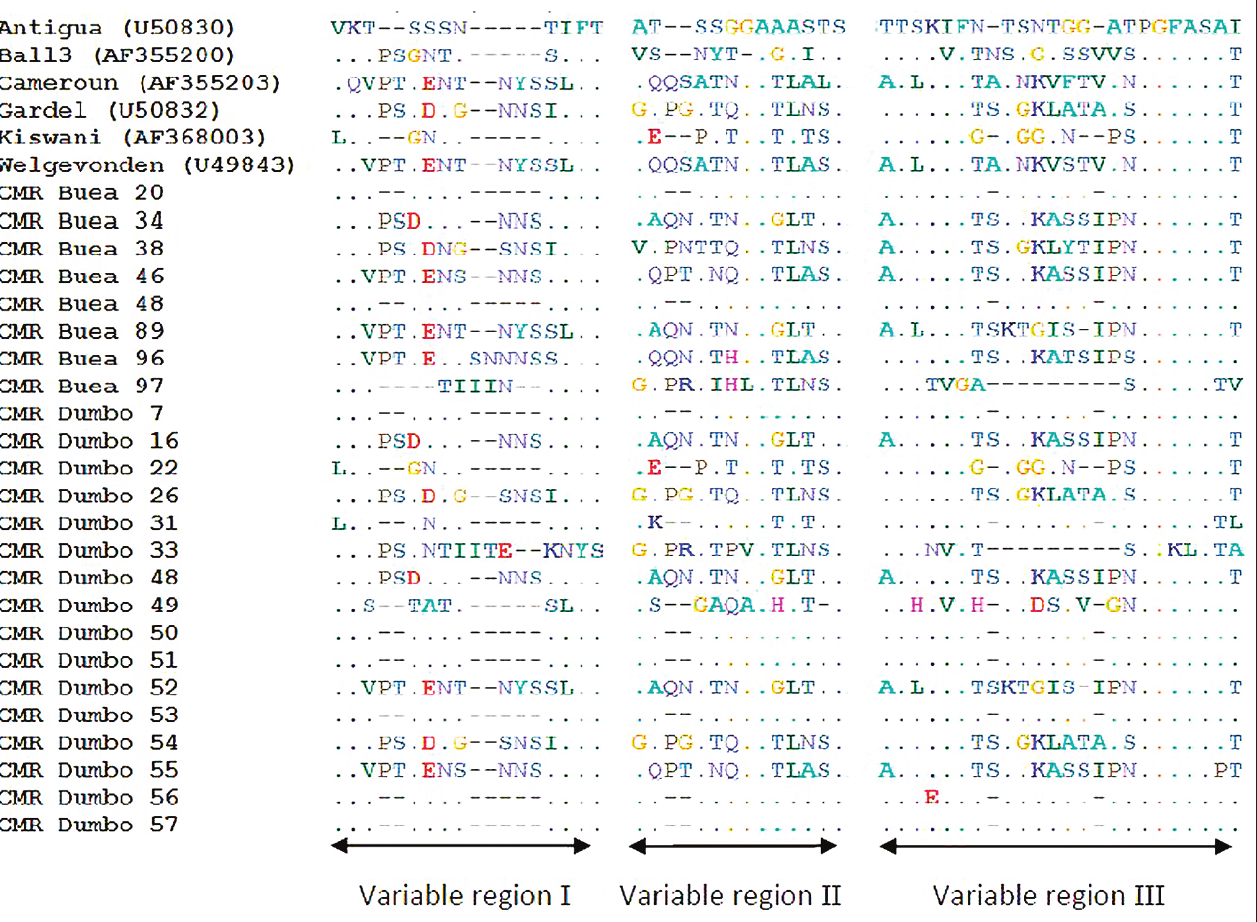
FIGURE 1: Comparison of the amino acid sequences at the three variable regions of the MAPI coding sequences of Ehrlichia ruminantium strains from Cameroon and six reference strains (accession number put in parentheses). TABLE 1: Classification of the Cameroonian Ehrlichia ruminantium strains based on the percentage identities † at the nucleotide level and the number of genotypes in each group. Group Ehrlichia ruminantium strain(s) Nucleotide sequence identity ( %